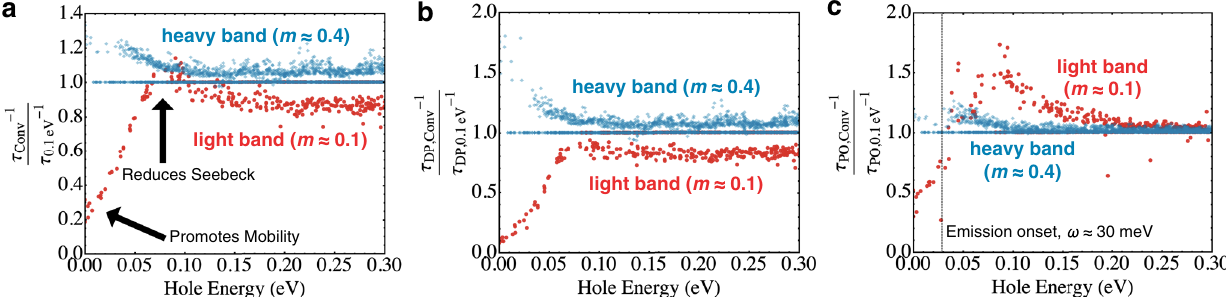
Fig. 4 Scattering rate ratios (converged versus 0.1 eV offset) of CaZnMgSb 2 at 600 K. A value above (below) unity indicates that scattering increases (decreases) due to convergence. The energy scale is zero-referenced to the VBM. a The overall scattering rate ratio. b The DPS ratio, whereby the upper band only increases in scattering, while the lower band only decreases in scattering. c The POS ratio, whereby both bands increase in scattering past the emission onset.